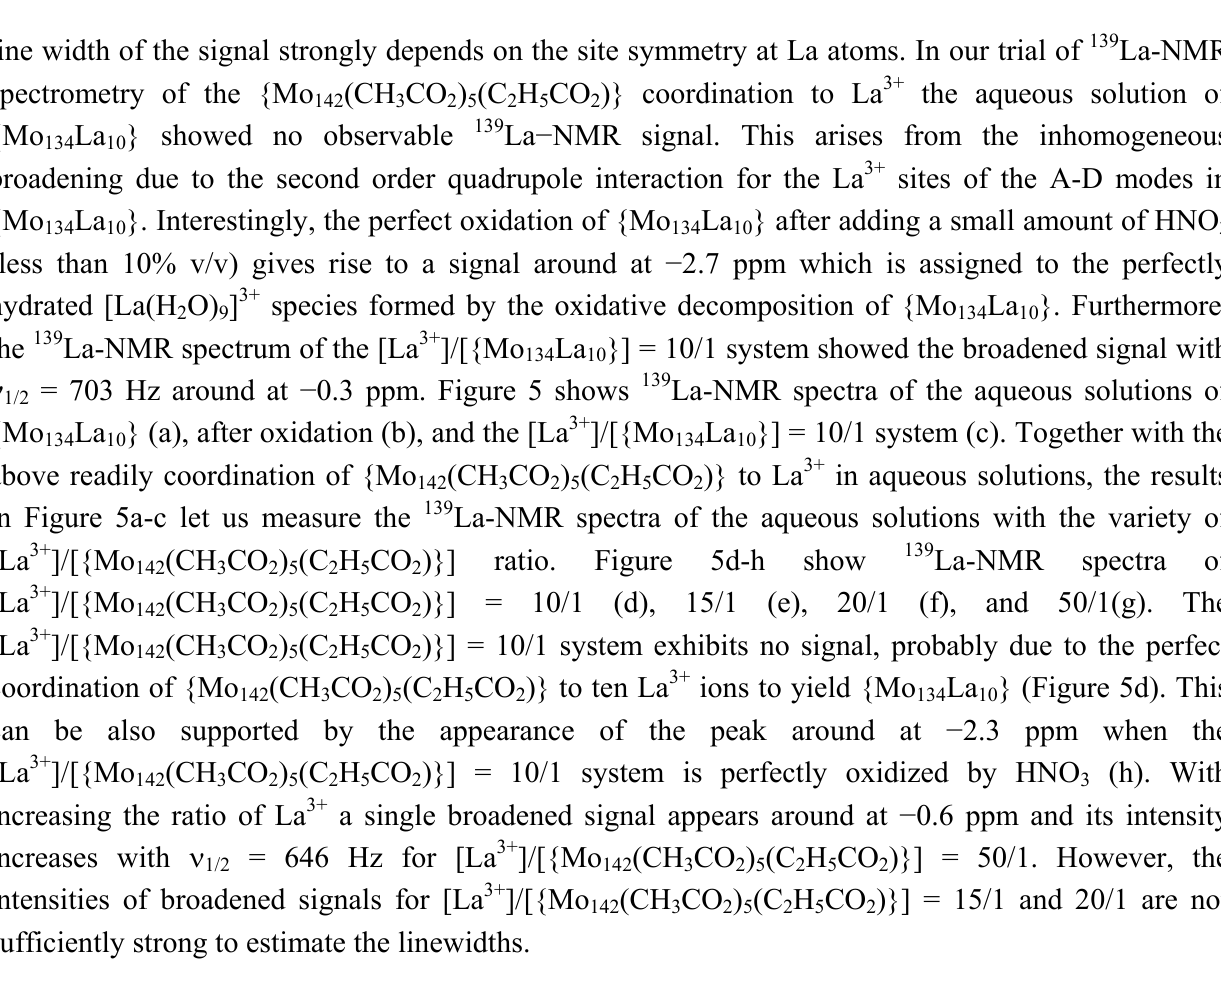
(b); 3 (CH CO ) (C H CO )} and 142 3 2 5 2 5 2 (f); and 50 mM LaCl (g); 3 3